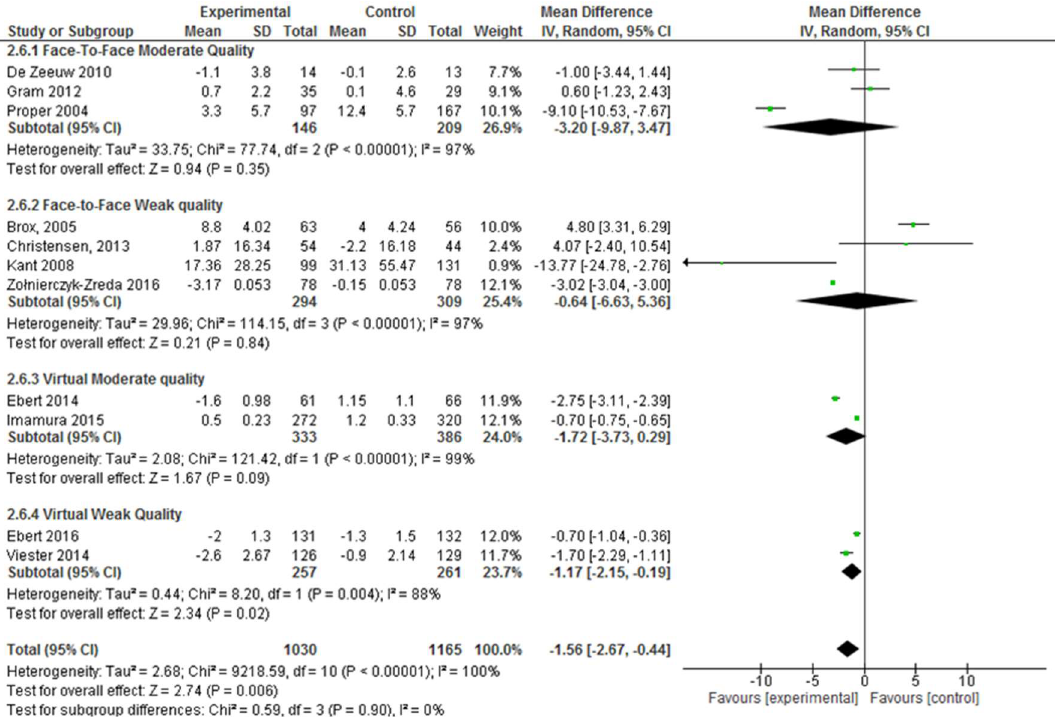
Figure 3. Forest plot of the effectiveness of face-to-face and virtual workplace interventions for reducing absenteeism according to the quality of the studies.